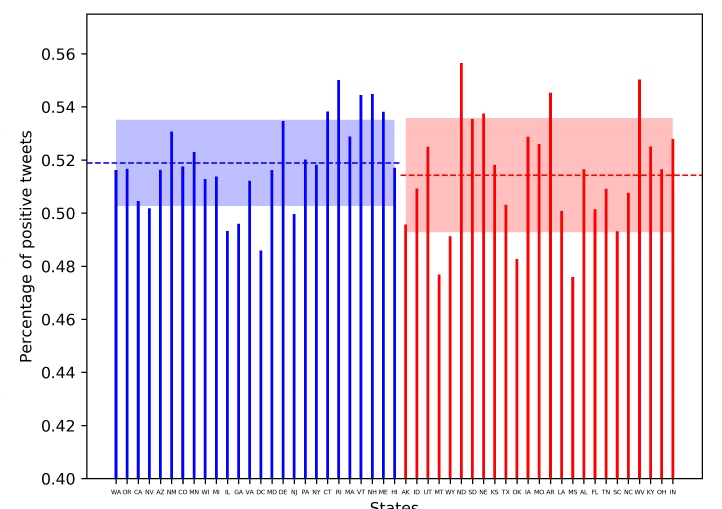
Figure 8. Mean and standard deviation in the fraction of positive sentiment tweets F for the blue and red states in